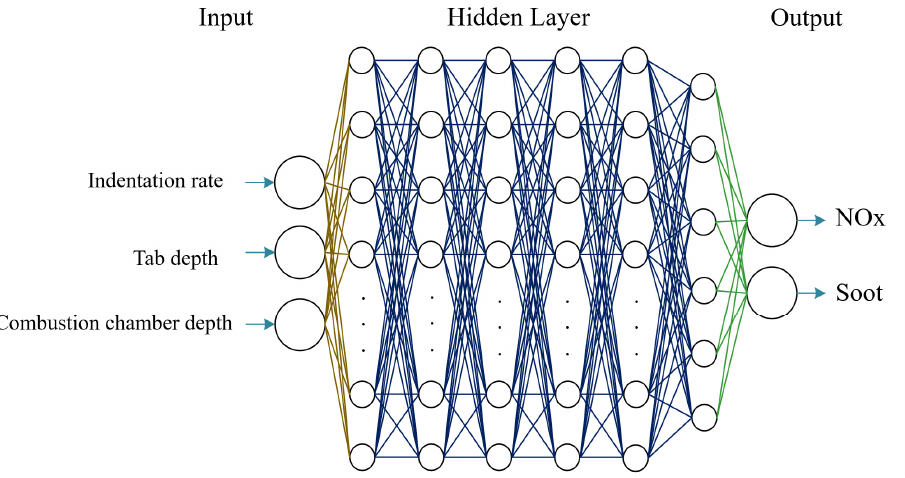
Figure 4. ANN structure diagram.